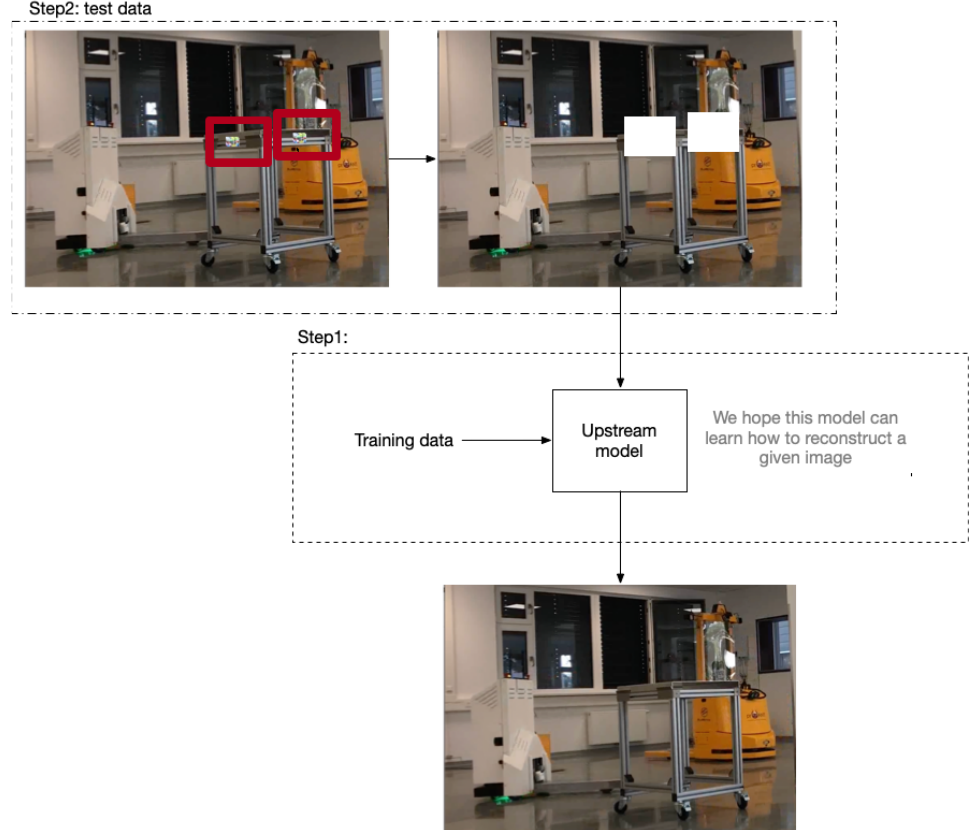
Figure 5. This figure represents the reconstruction of the image with